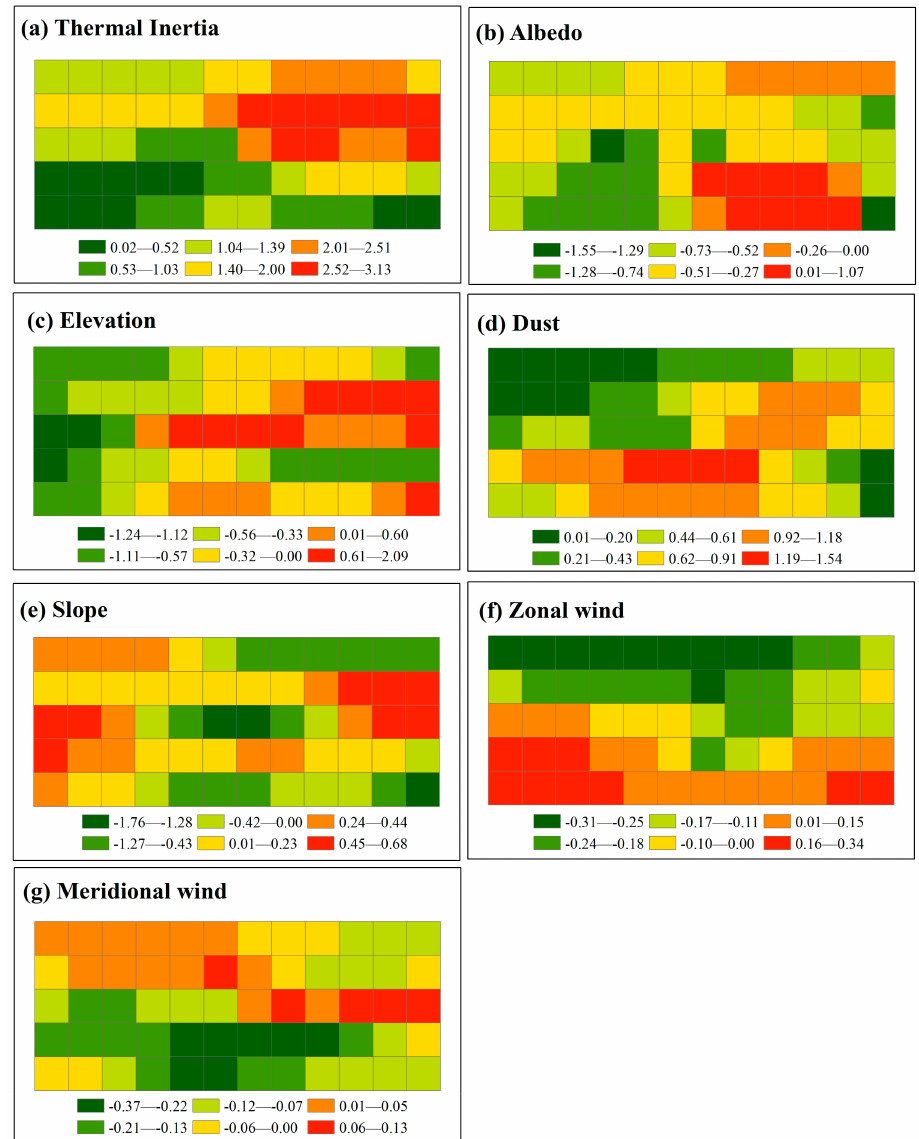
Figure 11. The distribution of the coefficients of the affecting factors (thermal inertia ( a ), albedo ( b ), elevation ( c ), dust ( d ), slope ( e ), zonal wind ( f ), and meridional wind ( g ) for SAT. Unlike SAT, the thermal inertia had a negative correlation on STR across the study area, and the Av and AHv geological units with steep terrain and high elevation in the east have the greatest negative influence (Figure 12a). The influence of albedo on STR was negative in the southwestern region, and positive in the east (Figure 12b). Dust had a negative effect on STR in most areas except for some areas in the central region, and the negative effect was greatest in the southwest (Figure 12d). The LL clusters of STR (Figure 7) were greatly affected by the negative impact of albedo (Figure 12b) and dust (Figure 12d). Slope exhibited a great negative effect on the STR lHl and eHt geological units in the central, while other regions exhibited positive effects (Figure 12e). The reason for this difference can be explained by the sheltering effect of the mountains on both sides of the basin because the east, west, and south sides of the study area are surrounded by mountains. The relationship between meridional wind and STR was positive in the study area, and the degree of influence increased from north to south (Figure